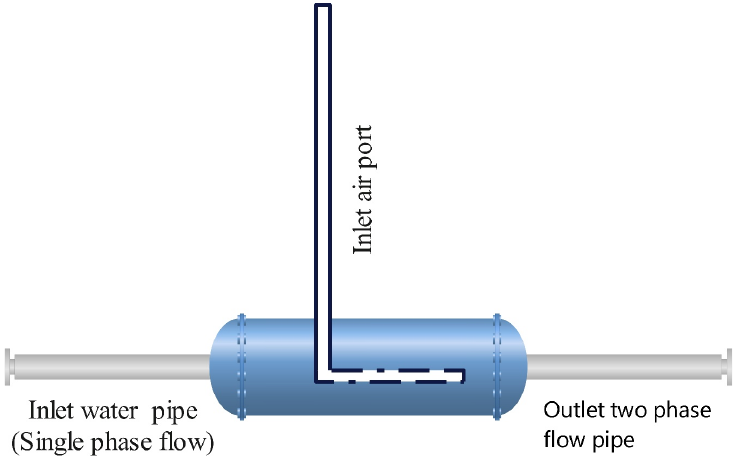
Figure 3. Schematic diagram for the mixing chamber.